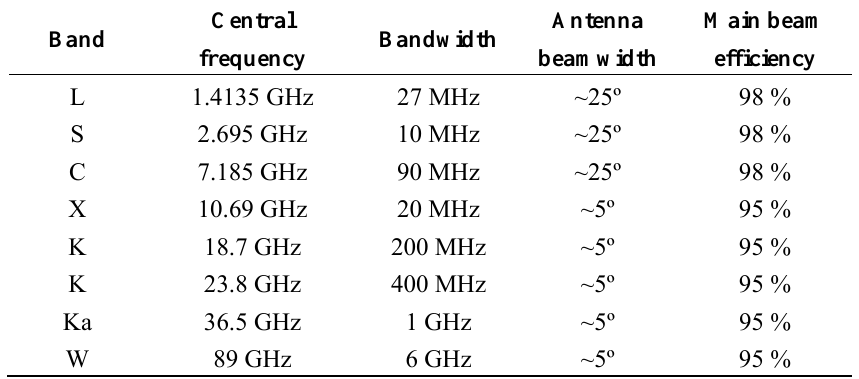
Table 2. MERITXELL microwave radiometer bands and antenna